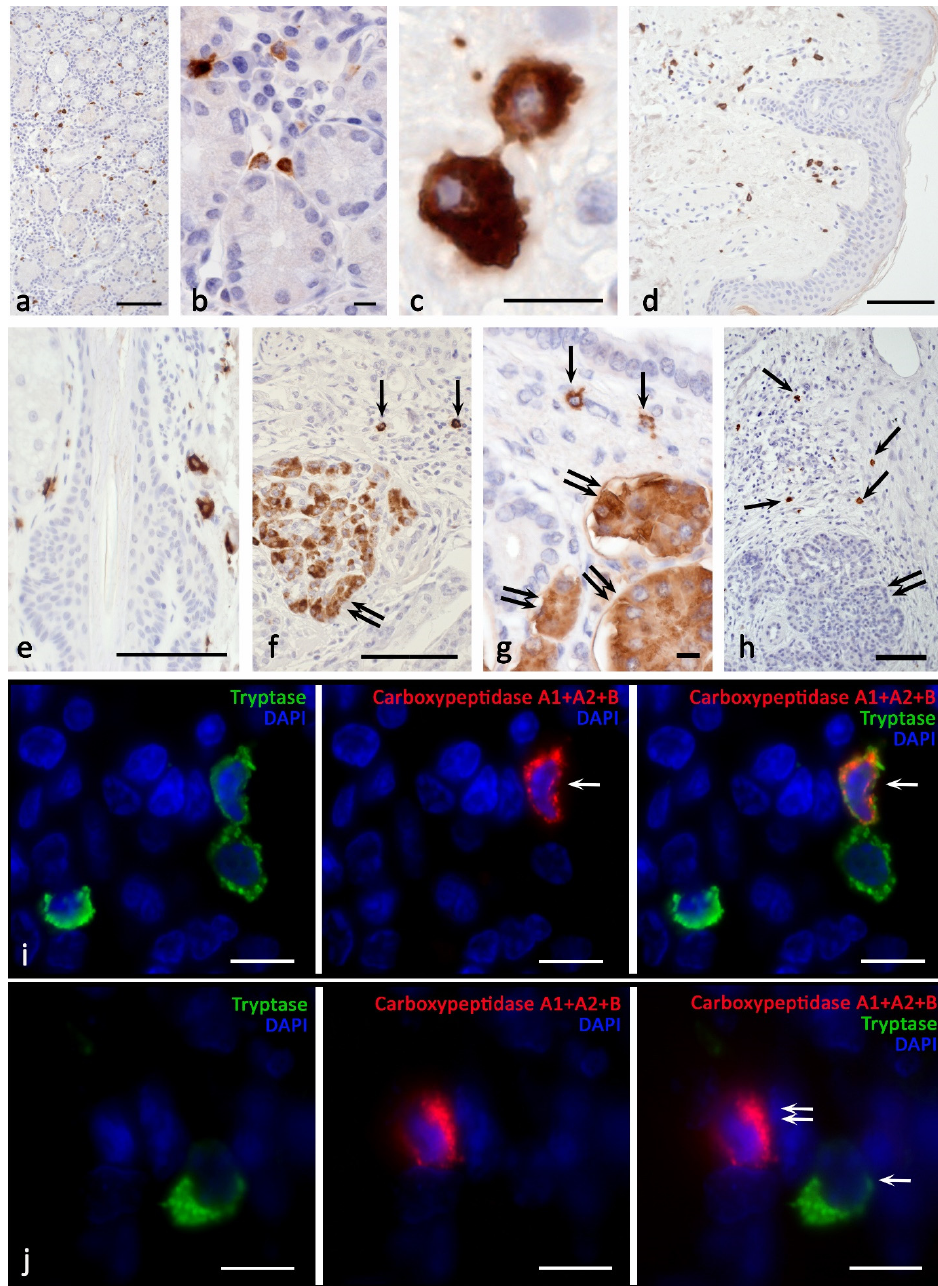
Figure 6. Carboxypeptidases in human mast cells. Primary antibodies used: ( a – g , i , j ) Rabbit mono- clonal [EPR12087(B)] to Carboxypeptidase A1+A2+B (ab181146) (AbCam). ( h ) Rabbit polyclonal to CPA3 antibody (ab251696) (AbCam). Secondary antibodies used: AmpliStain anti-Rabbit 1-Step HRP (#AS-R1-HRP), SDT GmbH, label-HRP. ( a – c ) Stomach. There is a positive reaction of mast cells of the mucous to the carboxypeptidases of the pancreas. ( d , e ) Skin. There is a staining of pancreatic carboxypeptidases in mast cells in the dermis ( d ) and hair follicle ( e ). ( f – g ) Pancreas. Pancreatic carboxypeptidases are detected both in mast cells (indicated by an arrow) and pancreatic exocrinocytes (indicated by a double arrow). ( h ) Pancreas. CPA3 is contained in mast cells (indicated by an arrow) and is absent in pancreatic exocrinocytes (double arrow). ( i ) Stomach. A tryptase- positive MC containing pancreatic carboxypeptidases (indicated by an arrow) is detected. ( j ) Stomach. A cell positive for pancreatic carboxypeptidase is visualized (arrow) and tryptase-positive mast cell is visible (double arrow). Scale bar: 100 µ m ( a , d , e , f , h ), 10 µ m (the